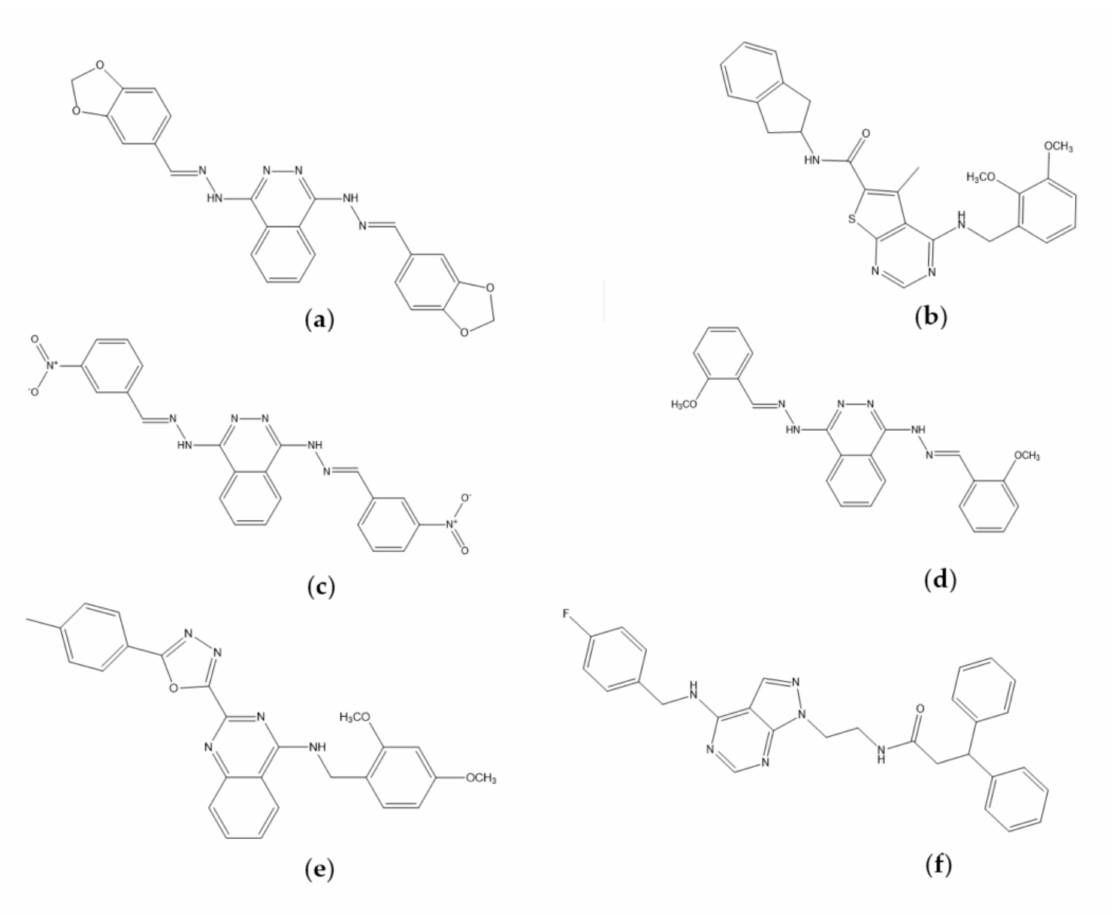
Figure 4. Chemical structure of ( a ) ZINC08398597, ( b ) ZINC12047553, ( c ) ZINC16525481, ( d ) ZINC17418102, ( e ) ZINC21942954, and ( f )